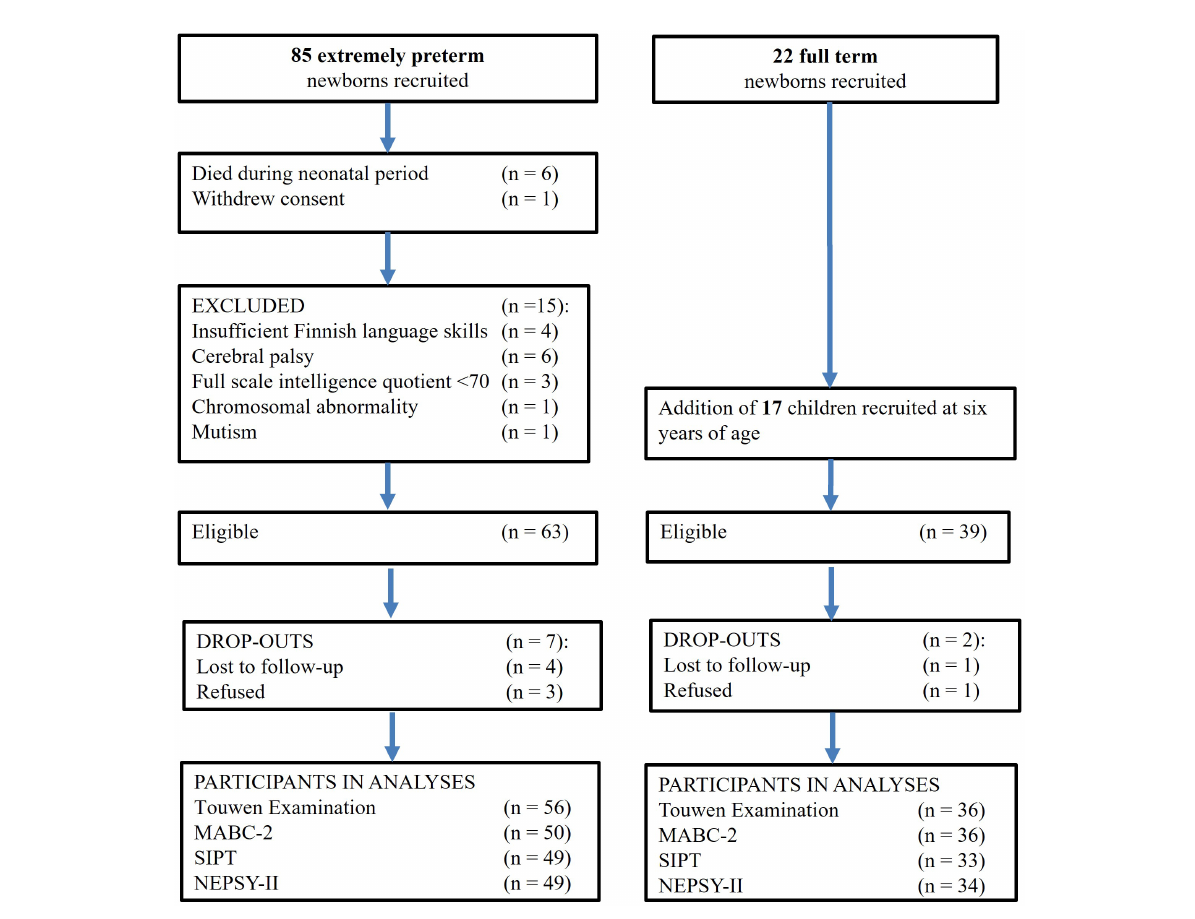
FIGURE 1 Flow chart of participants in the